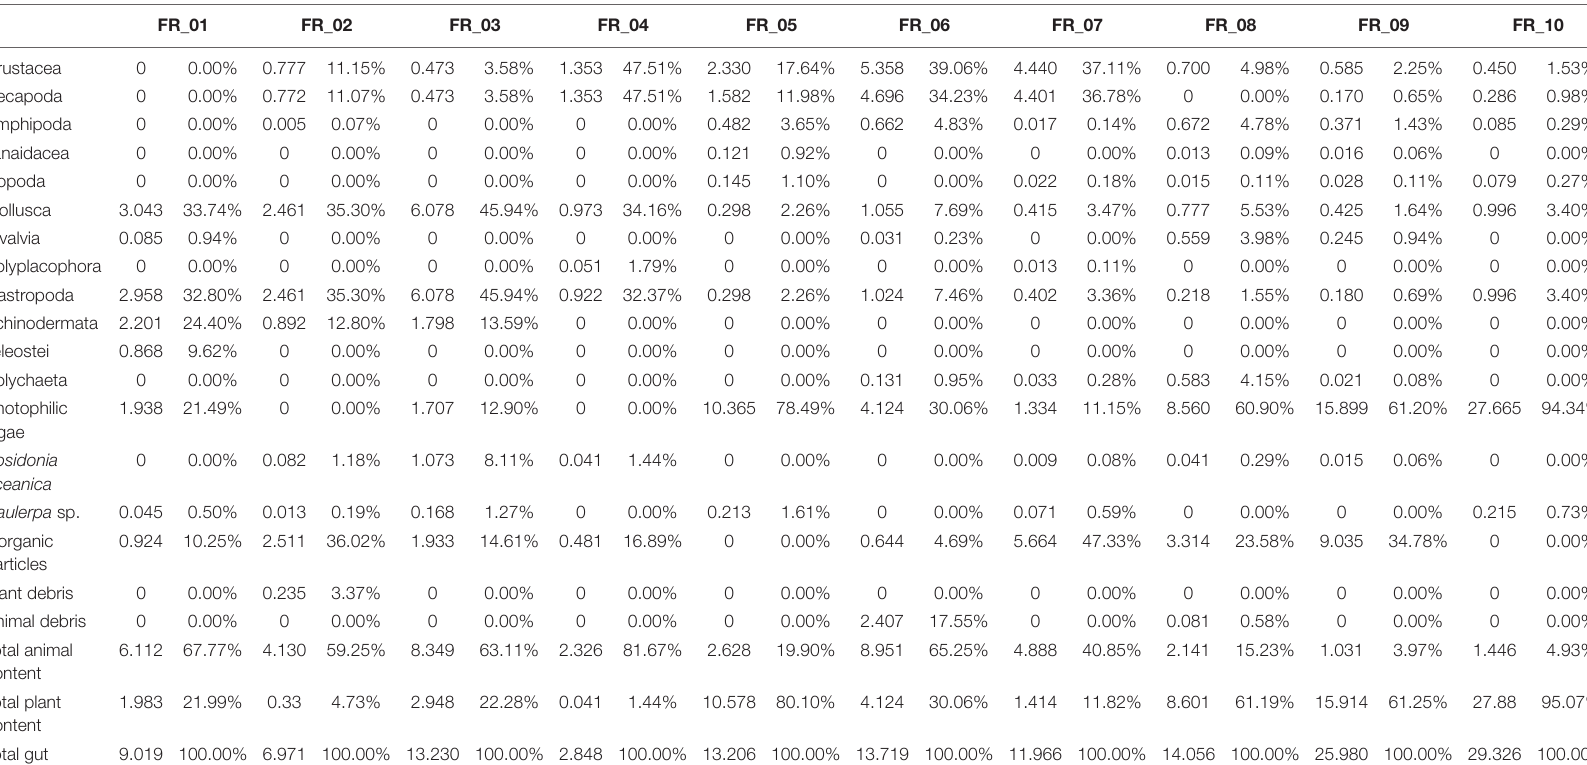
TABLE 2 | Diet composition in terms of biomass (g, left) and relative percentage composition (right) for each of the 10 Diplodus sargus individuals